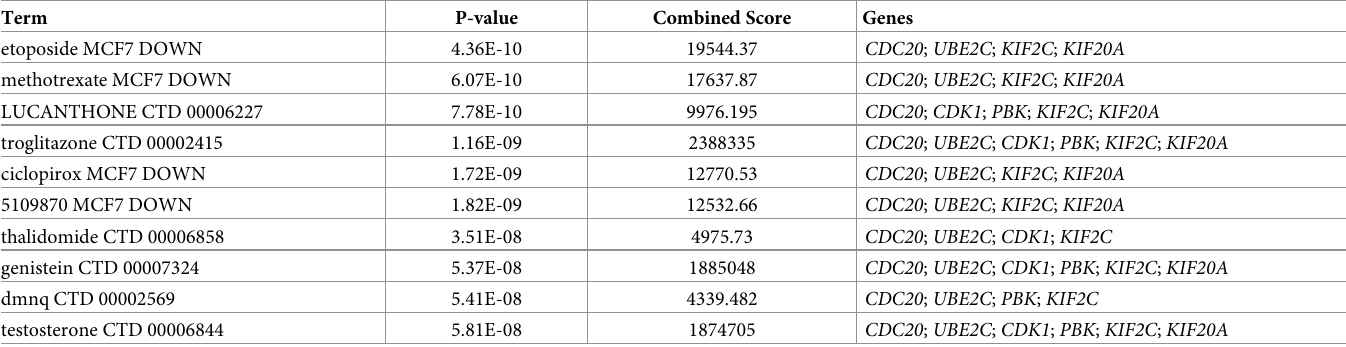
Table 5. COVID-19 myocarditis gene-targeted